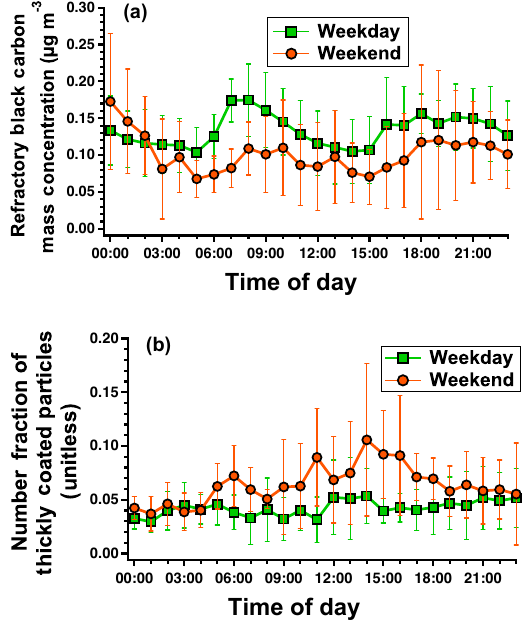
Figure 6. Mean diurnal cycle of ambient (a) black carbon mass concentration, and (b) number fraction of particles that are thickly coated ( f ), averaged over the entire measurement campaign and shown separately for weekdays and weekends. Error bars are 95% confidence intervals using the Student’s t distribution and computed using day-to-day variability in each hourly average. Weekdays are defined as Tuesday through Thursday, and weekends are defined as Sundays.